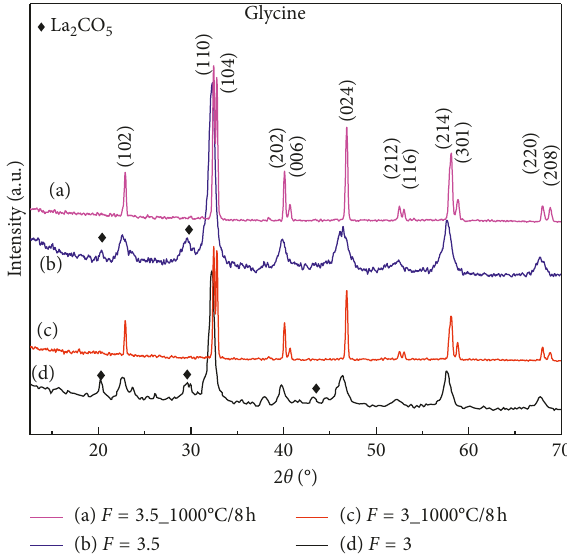
Figure 2: XRD patterns of LaMnO before and after annealing at 1000 ° C in 8h. Figure 1: XRD patterns of LaMnO 3 3, 3.5, (cid:31)